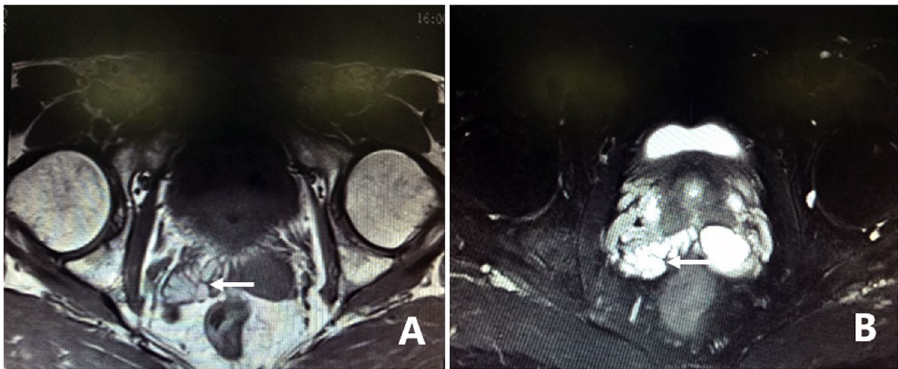
Figure 2. MRI image of an old hemorrhage in the right side of the SV. ( A ) This image shows high signal intensity in the right SV and low signal intensity in the left SV on T1WI. ( B ) This image shows similar high signal intensity in both sides of the SV on T2WI. This pattern suggests that an old hemorrhage is present in the right SV. There are slight dilatations and cystic changes in the right and left sides of the SV,